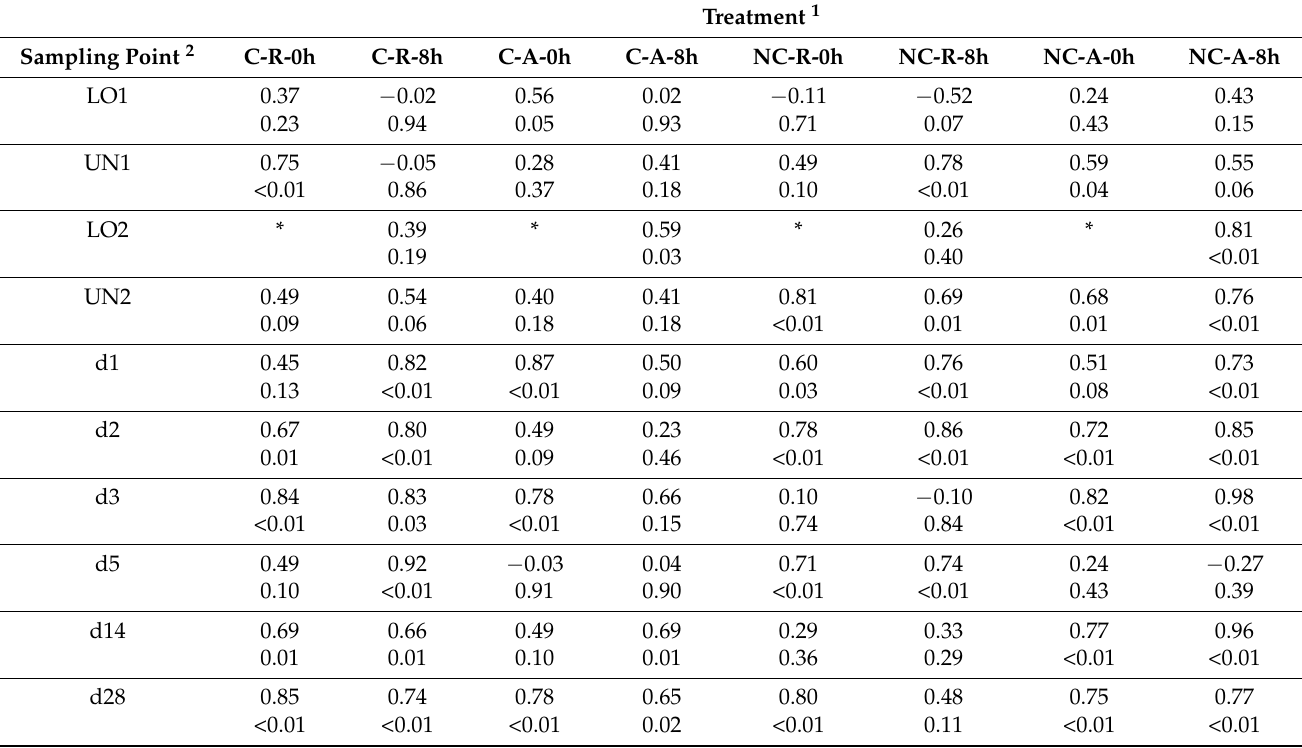
Table 2. Pearsons’s product moment correlation between Lactate Scout+ and a colorimetric assay for each treatment at each sampling